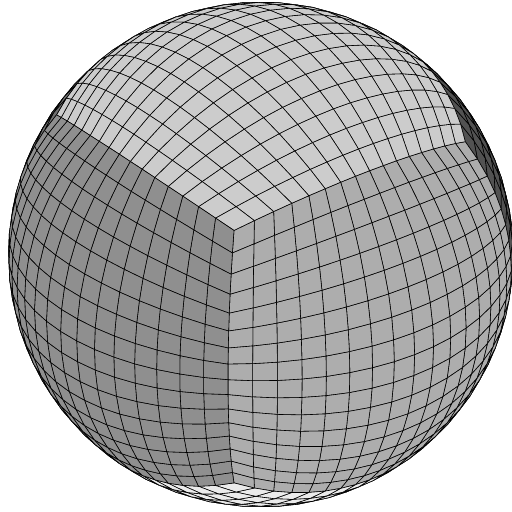
Figure 1. A 3-D view of the cubed-sphere grid shown here with n e = 16. Cubed-sphere faces are individually Fig. 1. A 3D view of the cubed-sphere grid shown here with n e = 16 . Cubed sphere faces are individually shaded.